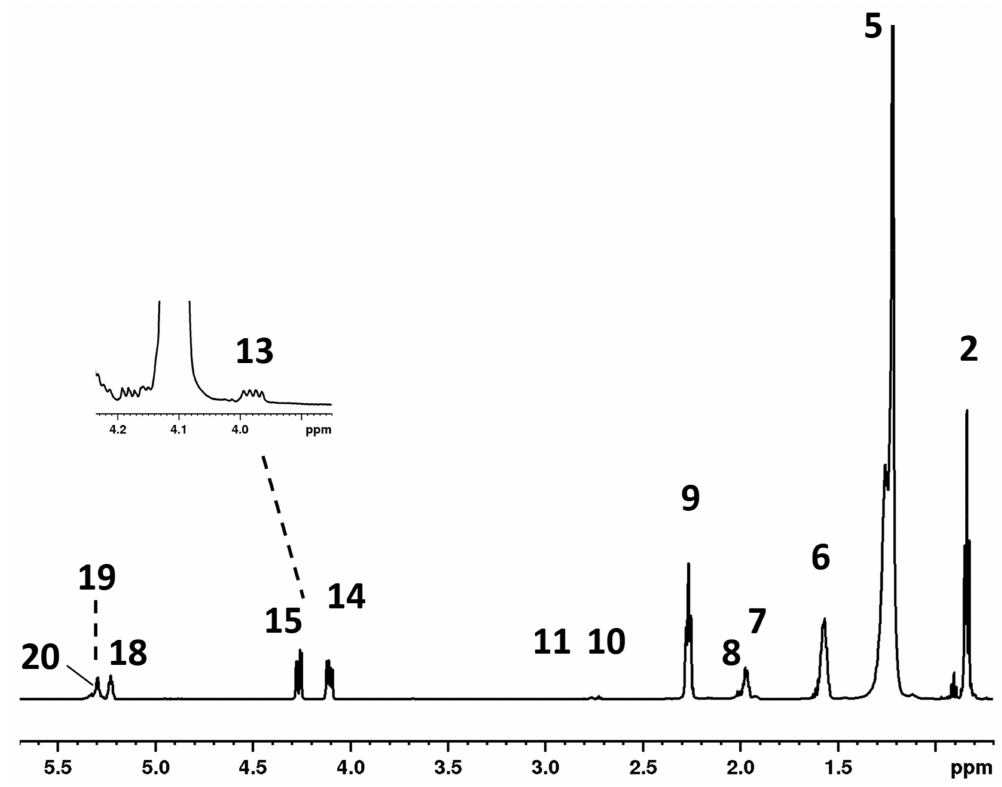
Figure 1. Selected region of 1 H spectrum of goat milk lipid fraction, recorded on a 600 MHz spectrometer, in CDCl 3 at 298 K. The inset shows resonances due to 1,3-DAG. Numbering refers to signals assigned in Table